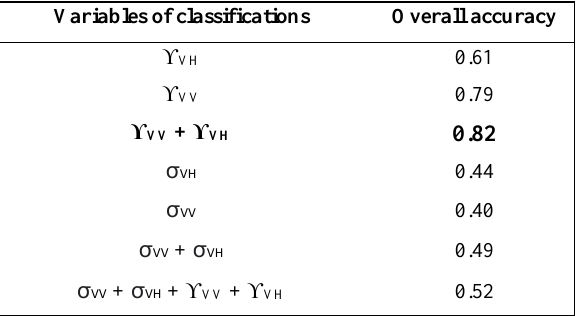
Table 2. Overall accuracies of the classifications under the various conditions of the variables.